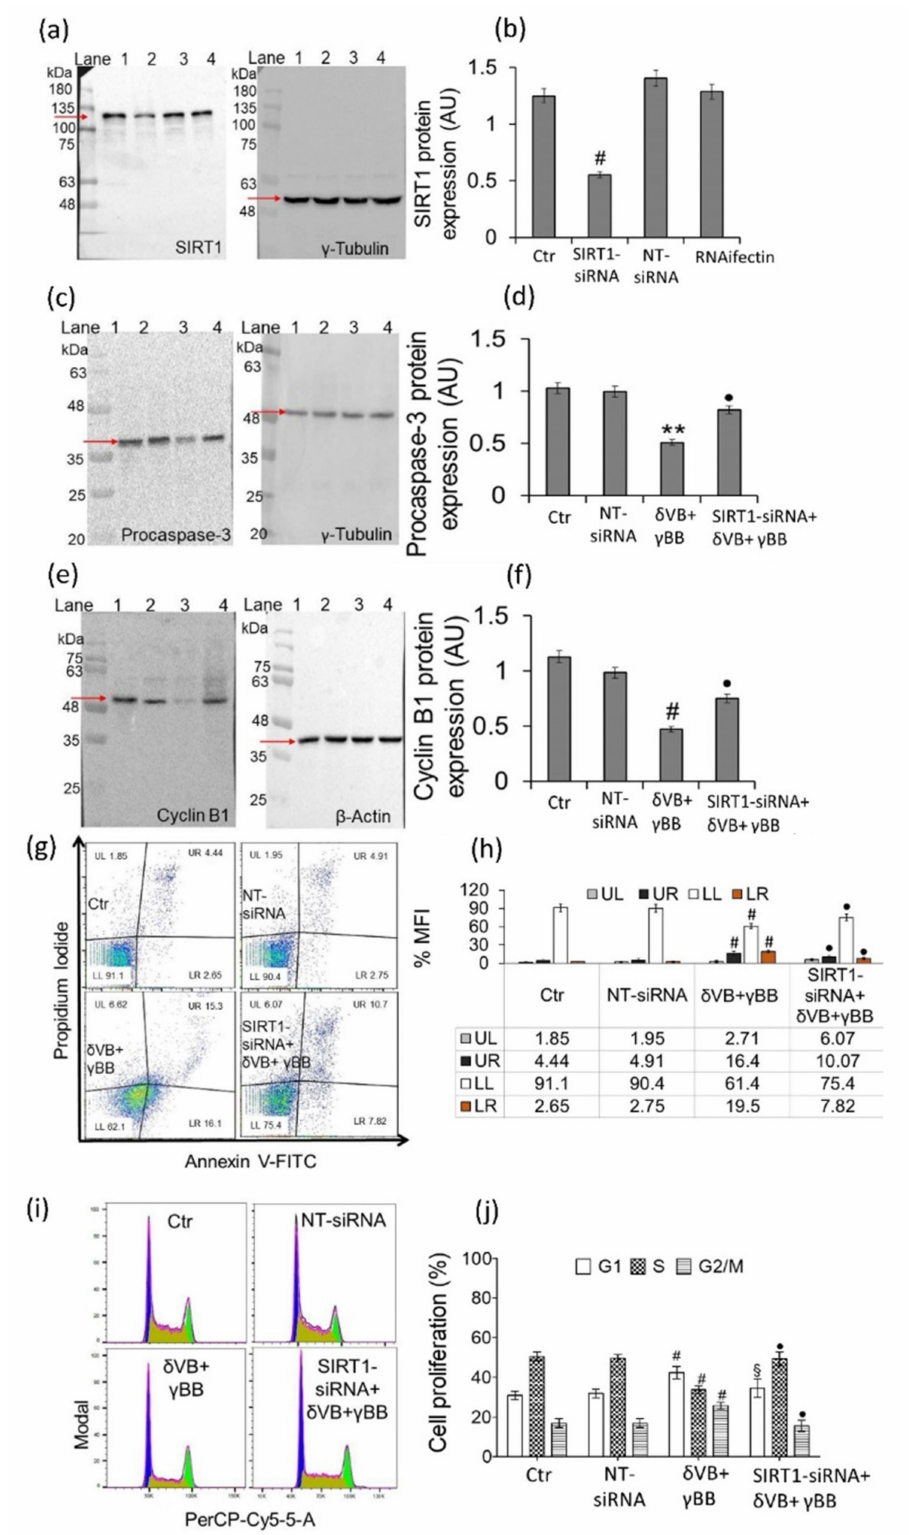
Figure 7. Cal 27 transient gene silencing of SIRT1. Cells were transfected with transfection reagent (RNAifectin), scramble siRNA (NT-siRNA), SIRT1-siRNA, or medium (Ctr). Treatments with betaines (48 h) were performed on transfected (SIRT1-siRNA + δ VB + γ BB) and non-transfected cells ( δ VB + γ BB). After treatments, Western blots were performed to determine the expression levels of SIRT1, procaspase-3, and cyclin B1. ( a , b ) SIRT1 protein expression. Lane 1 = Ctr, lane 2 = SIRT1-siRNA, lane